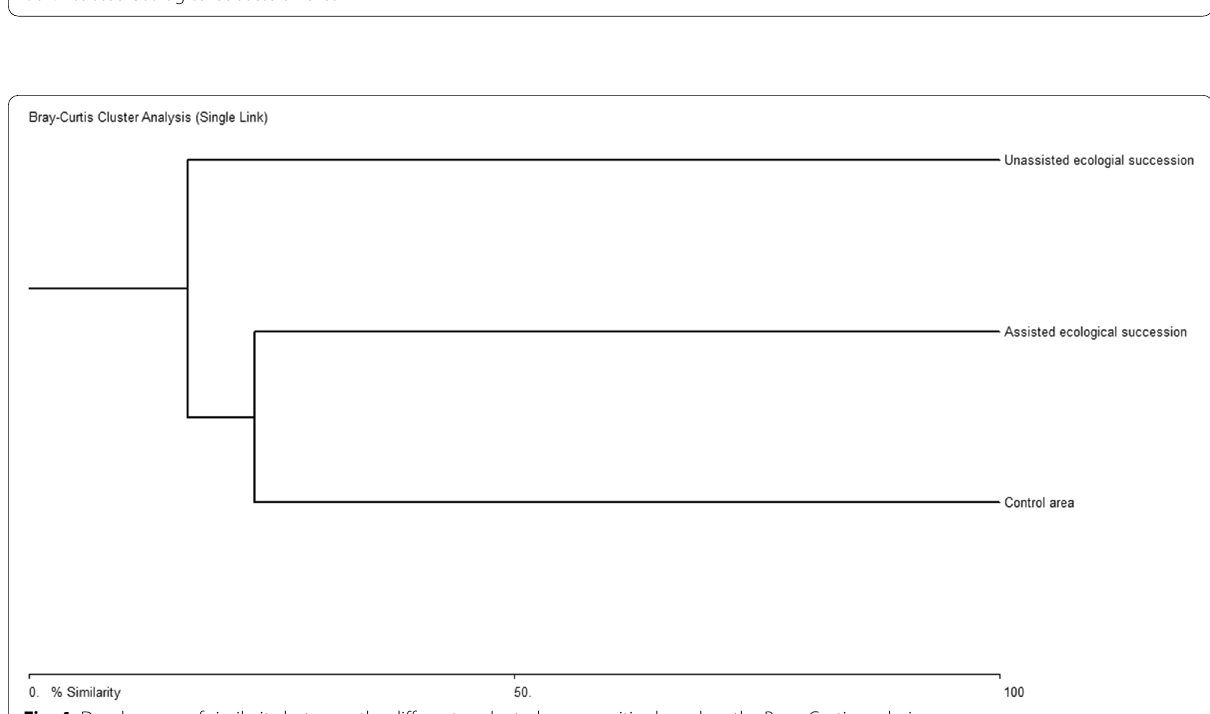
Fig. 4 Dendrogram of similarity between the different evaluated communities based on the Bray–Curtis